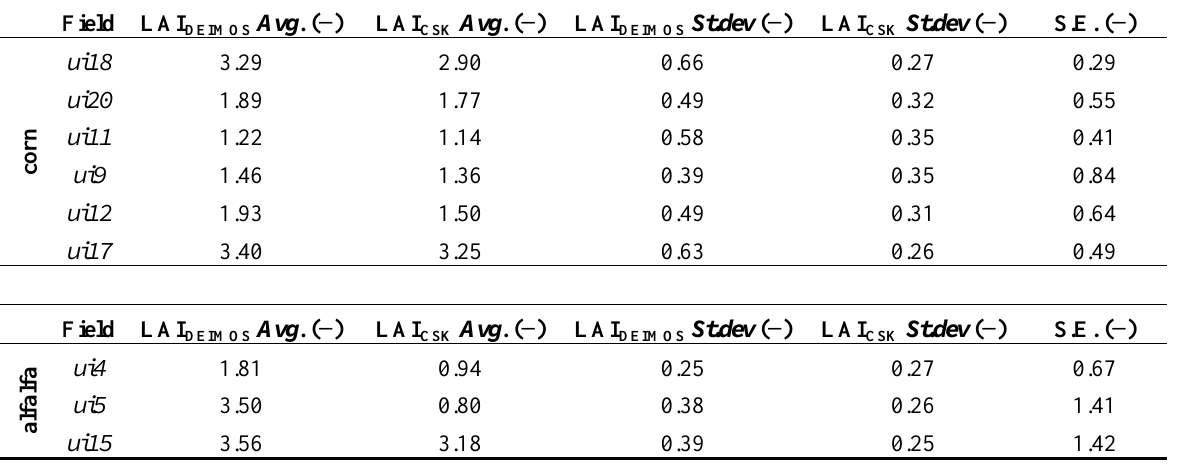
Table 3. Comparison between LAI and LAI: field temporal average, temporal average CSK st.dev and S.E. calculated over corn ( ui09 , ui11 , ui12 , ui17 , ui18 , ui20 ) and alfalfa ( ui04 , ui05 , ui15 ) plots over the time